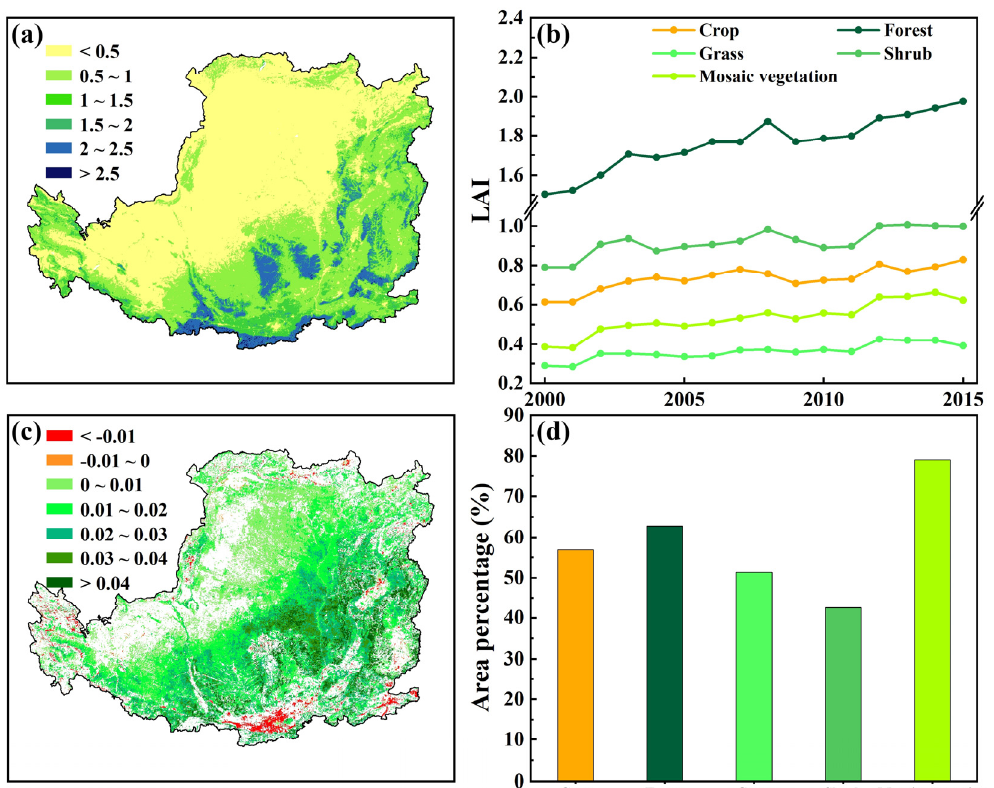
Figure 2. Spatiotemporal change in the LAI on the LP during 2000–2015: ( a ) the spatial distribution of the mean annual LAI; ( b ) the annual average LAI for different land cover types; ( c ) the spatial features of the annual trend of the LAI at the statistically significant level of 0.05; and ( d ) the area percentage of different land cover types with a significant increasing trend ( p < 0.05).